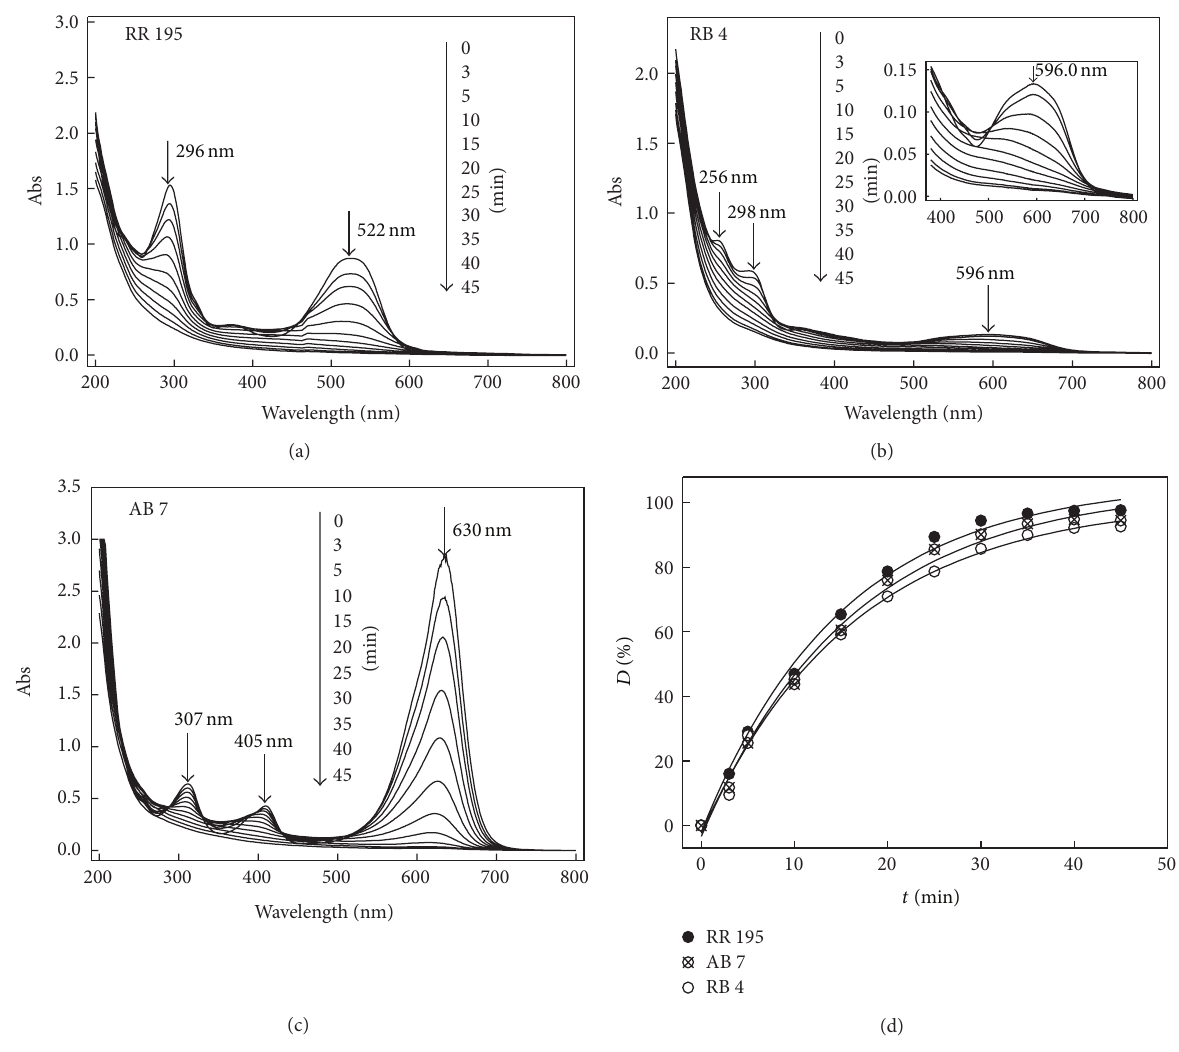
Figure 7: Degradation of three dyes with different molecular structures.